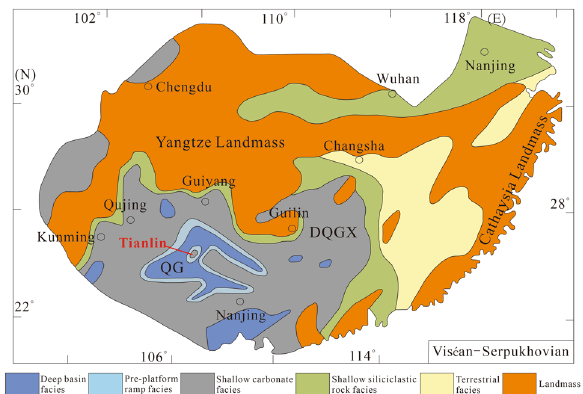
Figure 2. Paleogeographic map of southern China in Viséan-Serpukhovian (modified from Feng 23 , Yao 8 , and Maillet 24 ). This figure was obtained from articles by Feng 23 , Yao 8 and Maillet 24 respectively. The author modified the picture with CorelDRAW (version 2022, and the URL link: https:// www. corel draw. com/ cn/). QG Qian-Gui Basin, DQGX Dian-Qian-Gui-Xiang